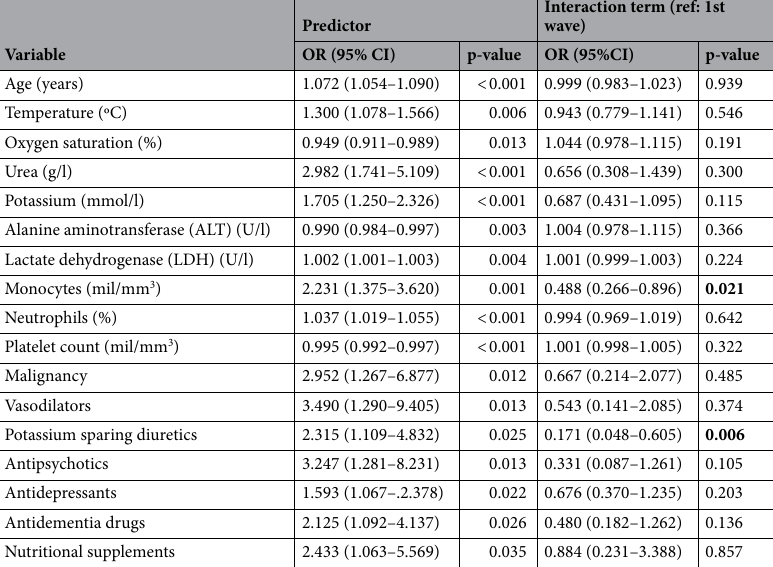
Table 3. Multivariate analysis of potential predictors of death in the two pandemic waves, Aragon, Spain, February–September,